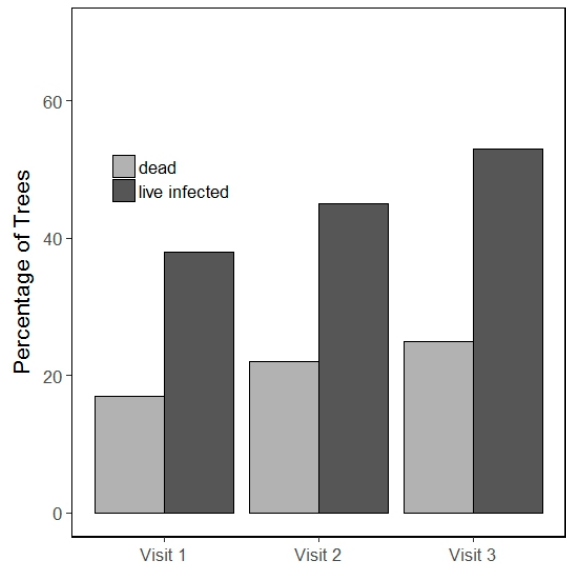
Figure 2. Incidence of white pine blister rust for live trees and whitebark pine mortality for the plots that were visited three times, approximately every five years between 2003 and 2014. Number of plots = 135.